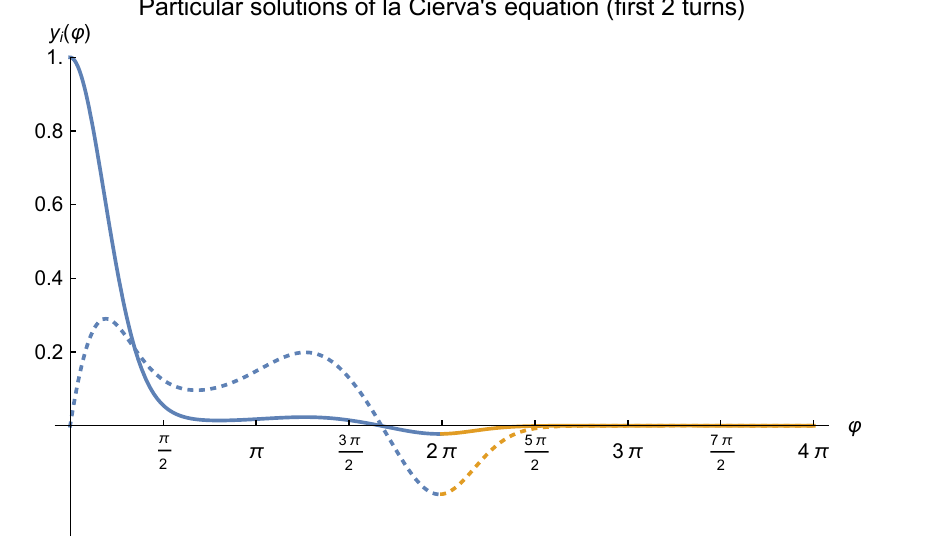
Figure 3. (Numerical approximations to the) particular solutions of la Cierva’s equation after two turns of the autogiro’s blade (c.f. Equation (46)). In this occassion, the blue lines have been used to distinguish the curves of both particular solutions in regard to the first turn to their prolongations to the second turn of the blade. In addition, notice that the dotted line corresponds to y 2 ( ϕ )